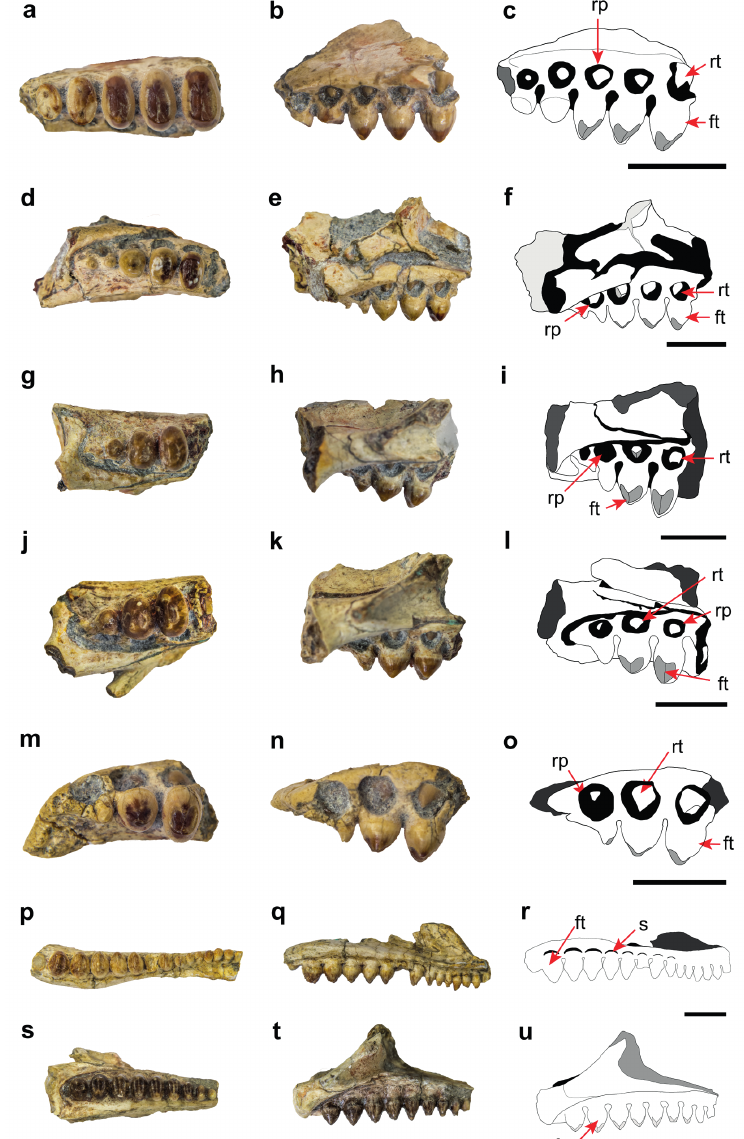
Figure 3 - Occlusal and labial view of upper jaws, a - c IGM4973, d - f IGM4974; g - i IGM4976; j - l IGM4977; m - o IGM4983; p - r IGM4980; s - u IGM4072. rp, resorption pit; s, scale. Scale bars equals